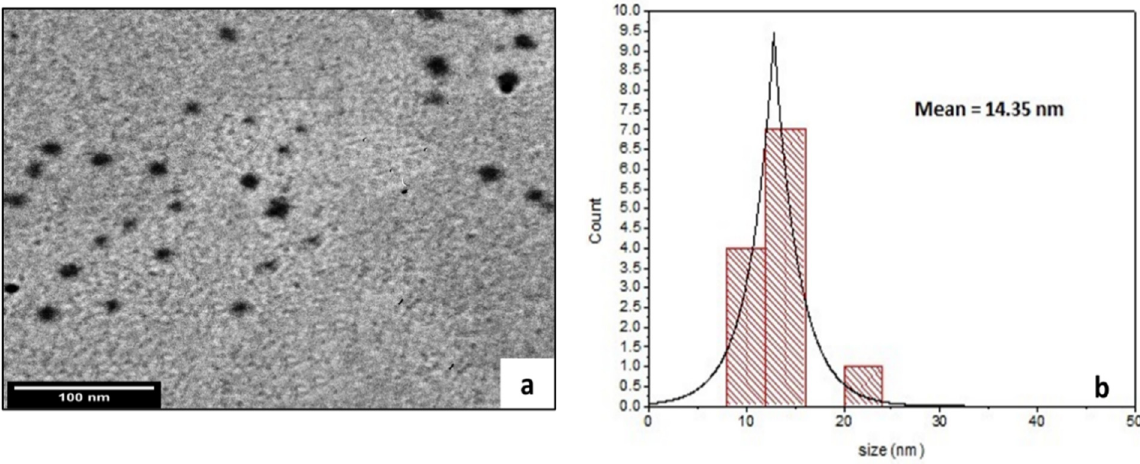
Figure 1. PXRD diffractograms of pristine CA, CA/ZnO, and CA@Ag (0.01, 0.05, 0.1) /ZnO hybrid membranes.